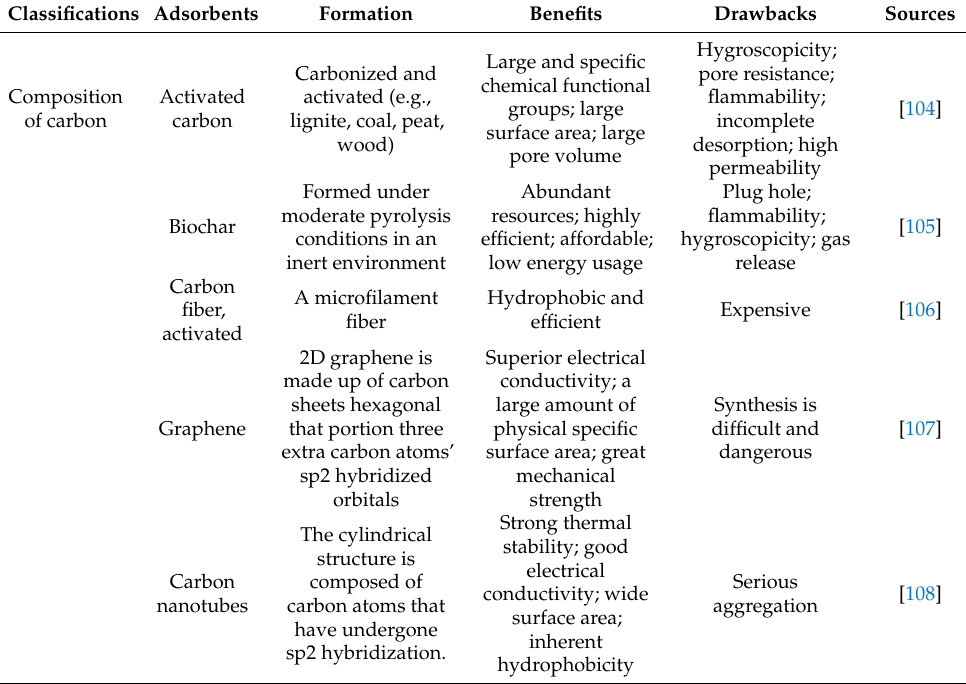
Figure 5. Adsorption procedures used for various carbon-based materials (CBMs). Table 3. Classification of various carbon compounds and their associated benefits and drawbacks.